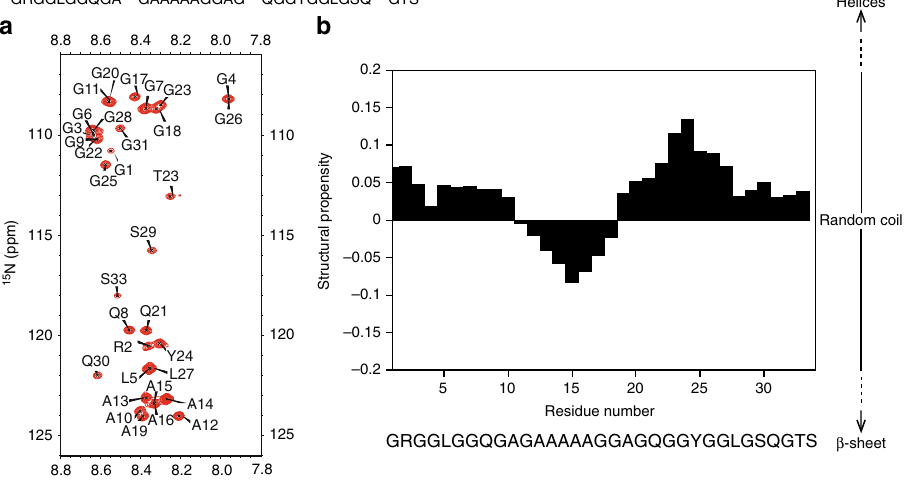
Fig. 2 Conformational differences between the polyalanine and glycine-rich regions. a 2D 1 H – 15 N HSQC spectrum of the 15-mer at pH 7 and 10 °C. b Structural propensity of the 15-mer at pH 7 and 10 °C